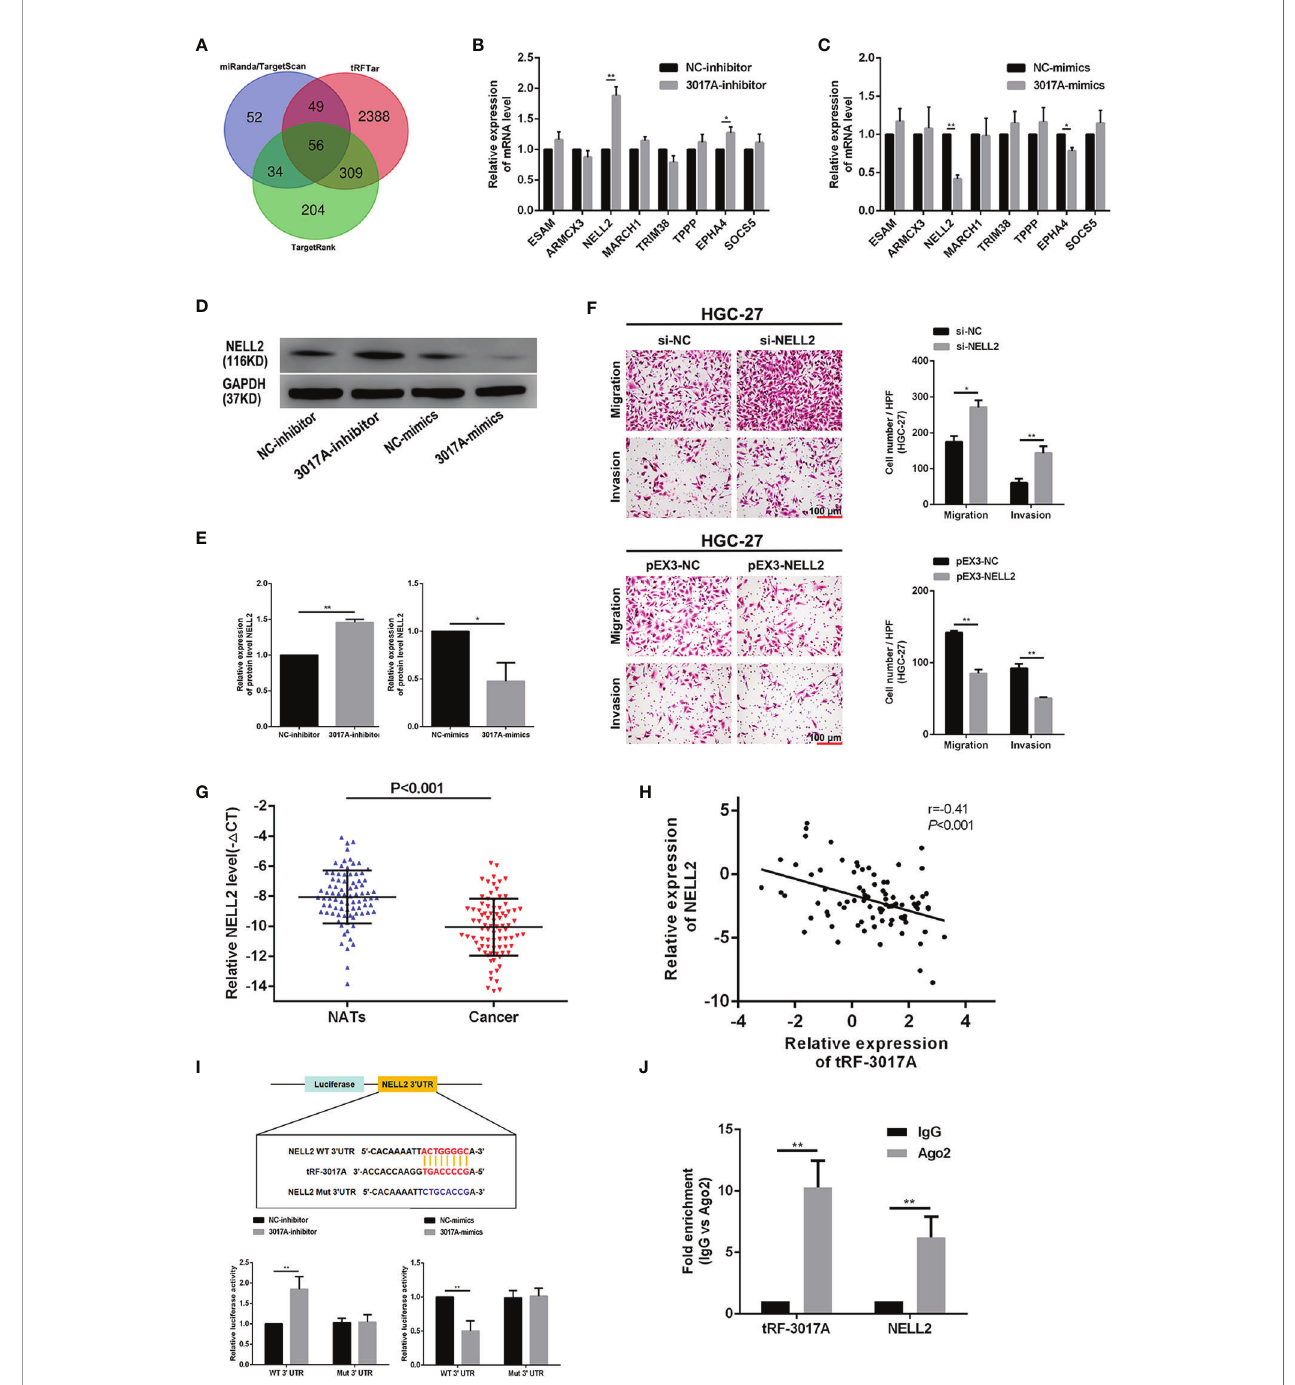
FIGURE 4 | tRF-3017A may play a role in regulating the migration and invasion of GC cells by regulating NELL2. (A) Venn diagram evaluated the overlapped genes among miRanda, TargetScan, TargetRank, and tRFTar predictions. (B, C) The expression levels of eight predicted target genes were performed to detect in AGS cell line after transfection with tRF-3017A-inhibitor or mimics by qRT-PCR. (D, E) The expression levels of NELL2 were detected in AGS cell line after transfection with tRF-3017A-inhibitor or mimics by western blot. (F) GC cell migration and invasion ability were detected after transfected with si-NELL2 and pEX3-NELL2. (G) Expression of NELL2 was downregulated (- D Ct, paired t test) in GC tissues relative to matched-paired NATs among 84 GC patients by qRT-PCR. (H) Correlation analysis of relative expressions of tRF-3017A and NELL2 and “ r ” is the correlation coef fi cient. (I) The luciferase activity of wild type NELL2 3 ’ UTR or mutant NELL2 3 ’ UTR after transfection with tRF-3017A mimics or 3017A-inhibitor and their corresponding NC in AGS cell line. (J) The result of the RIP based on Ago2 showed that tRF-3017A may exert its miRNA-like silencing effect by combining Ago2, thus targeting NELL2. Representative images and bar graphs were depicted. Data are shown as mean ± SD. NC, negative control. *P < 0.05; **P <